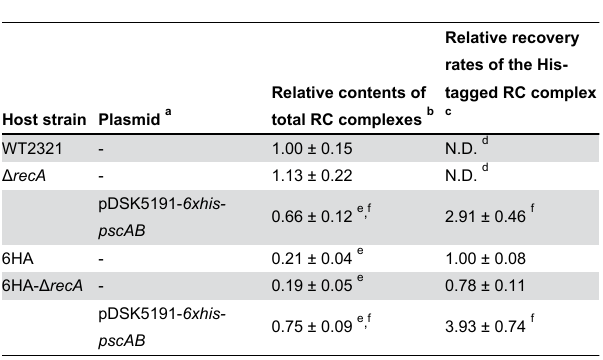
Table 5. Relative contents of total RC complexes in various C. tepidum strains and relative recovery rates of His-tagged